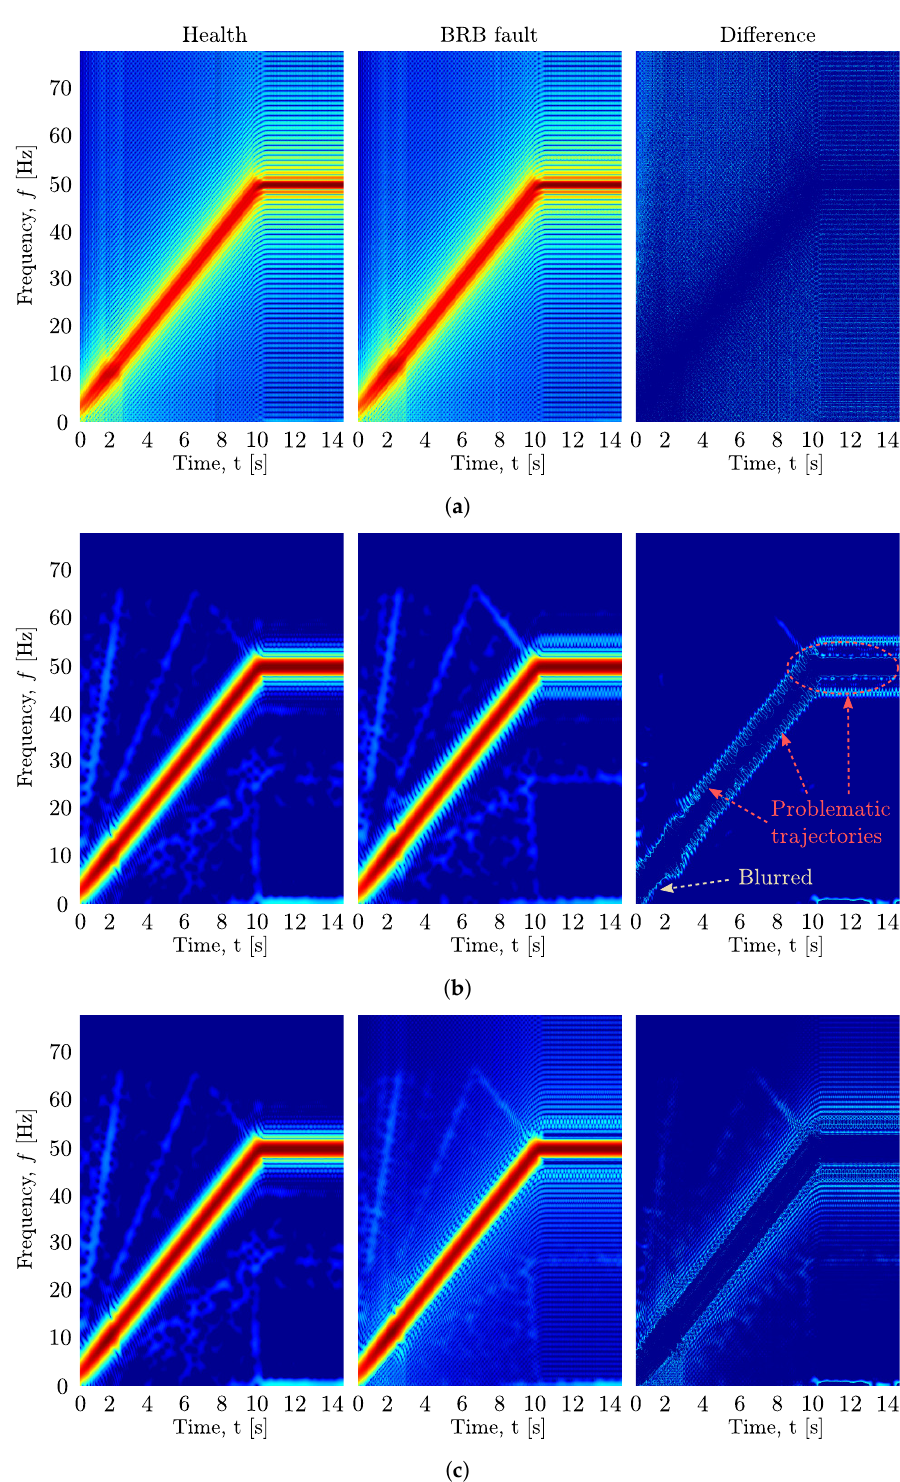
Figure 5. Time-frequency spectra of the experimental current signal with (Left) health and (Center) fault condition, and (Right) the difference of these spectra. Comparison of Windowed Fourier Transform (WFT) with ( a ) a rectangular window; ( b ) a Hanning window; and ( c ) a Hamming